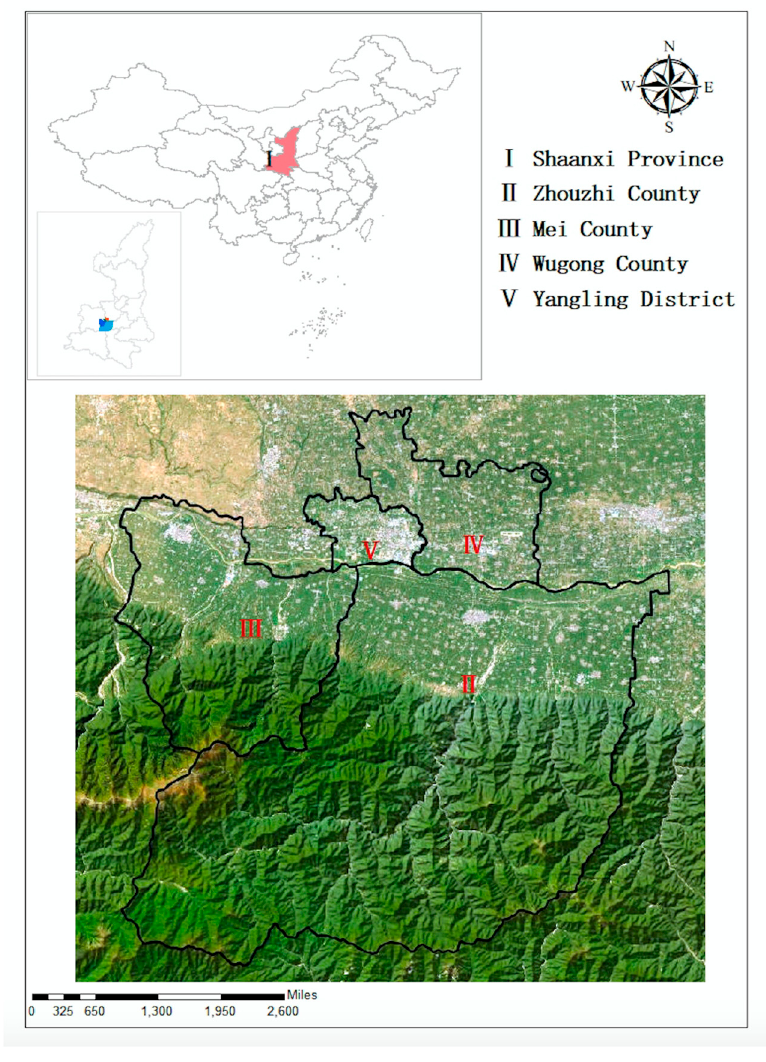
Figure 2. Location of the study sites in Shaanxi, China.